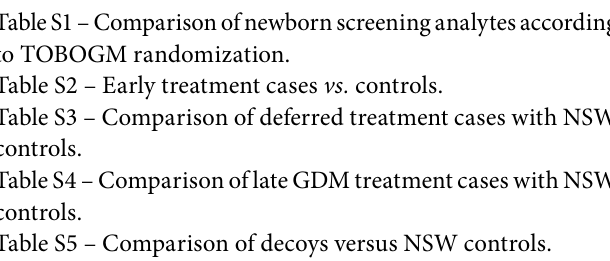
Table S1 – Comparison of newborn screening analytes according to TOBOGM randomization. Table S2 – Early treatment cases vs. controls. Table S3 – Comparison of deferred treatment cases with NSW controls. Table S4 – Comparison of late GDM treatment cases with NSW controls. Table S5 – Comparison of decoys versus NSW